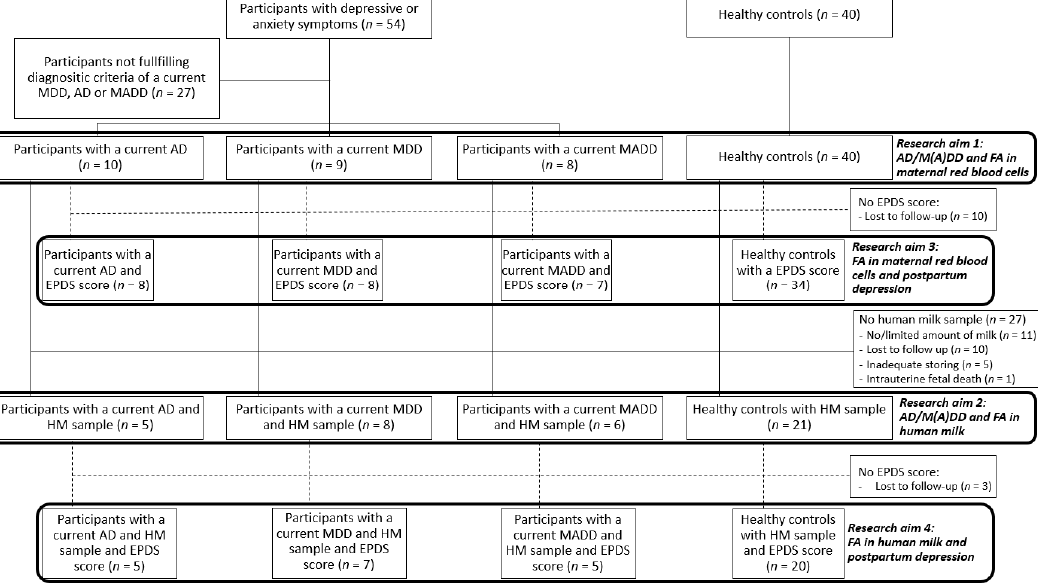
Figure 1. Flow chart of the subjects included in the study. Abbreviations used: AD, anxiety disorder; MDD, major depressive disorder; MADD, mixed anxiety–depressive disorder; FA, fatty acids; EPDS, Edinburgh Postnatal Depression Questionnaire; HM, human milk.